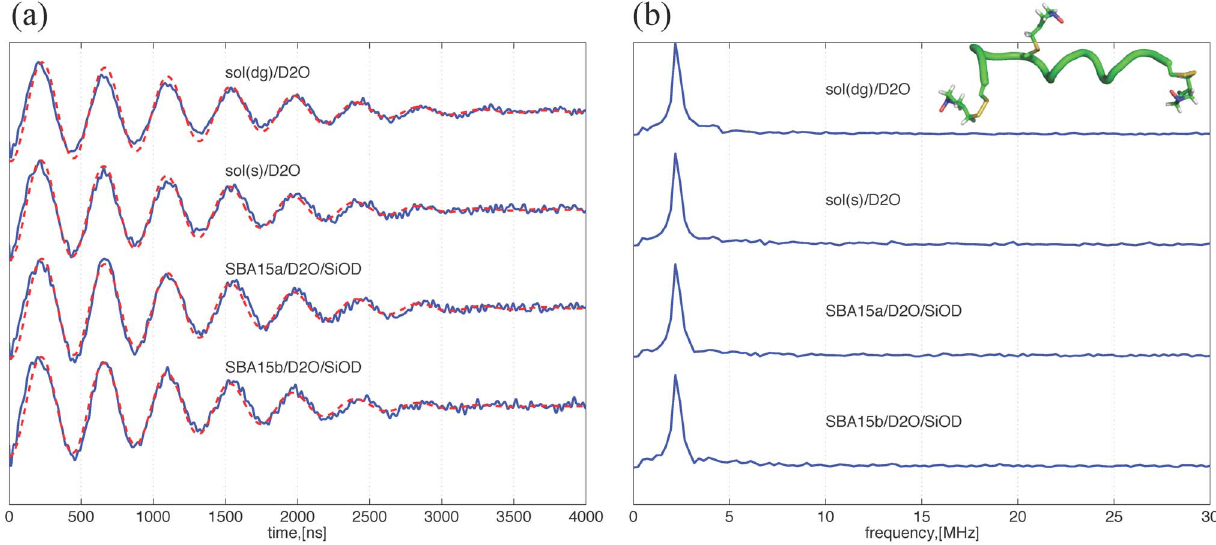
Figure 4. Water accessibility study of the PPm3-s by ESEEM. (a) Three-pulse ESEEM time-domain data (solid lines) after the removal of the exponential decaying function in the raw data. The modulation depth is directly correlated to the peak intensity of the FT-ESEEM and can be quantitatively characterized by the best-fit parameter k D (cf. Table 1). The dashed lines represent the theoretical fits to the experimental data using the equation described in Figure 3. (b) The FT-ESEEM data for the PPm3-s in various deuterated conditions. The peaks correspond to the Larmor frequency of nucleus 2 H, indicating the PPm3-s is surrounded by D 2 O. The inset shows a ribbon model of a PPm3 variant carrying three spin labels. doi:10.1371/journal.pone.0068264.g004 PLOS ONE |